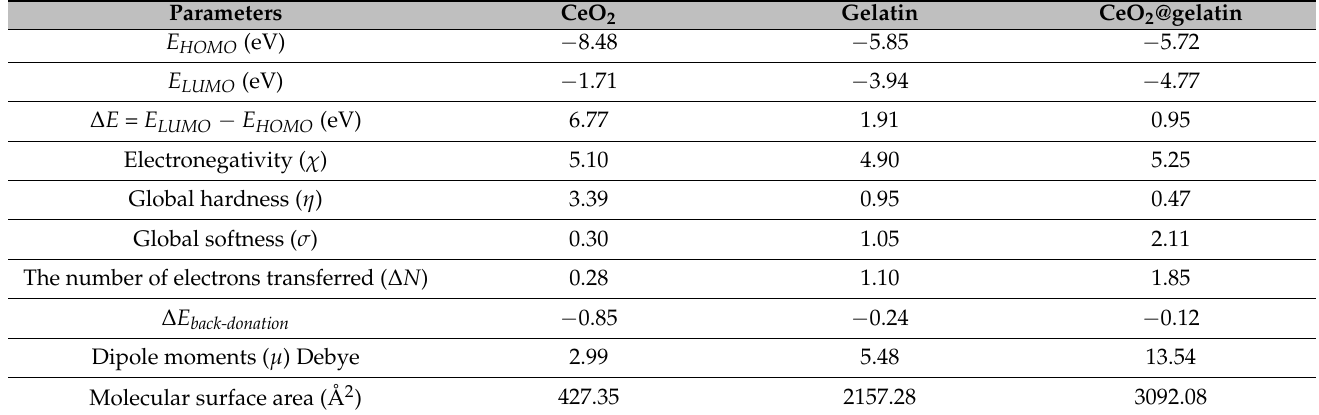
Table 3. DFT parameters for CeO 2 , gelatin and CeO 2 @gelatin